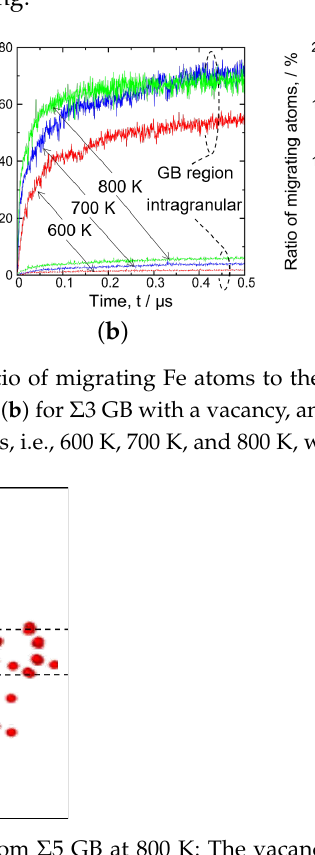
Figure 4. A vacancy de-trapped from Σ 5 GB at 800 K: The vacancy migration is represented by showing the only Fe atoms which migrated more than one lattice unit because these atoms migrate by exchanging a site with a vacancy. The dashed lines represent the boundaries of the initial GB